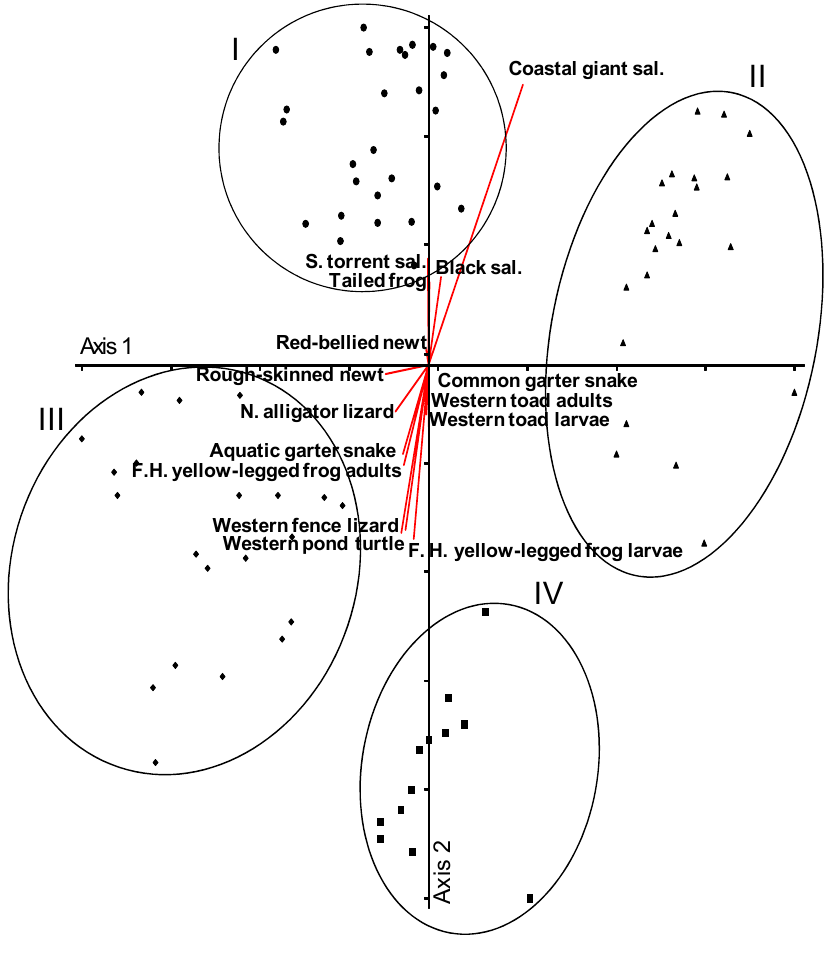
Figure 10. NMDS of 83 reaches in the Mattole watershed with the distributions of eleven amphibian and reptile species relative to the four channel types (descriptions in Figure